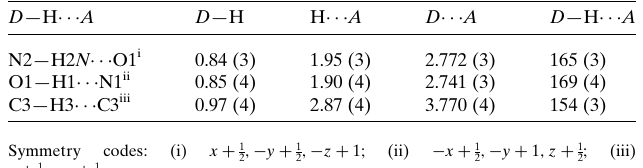
Table 1 Hydrogen-bond geometry (A˚ , (cid:4) ) for BIZ.